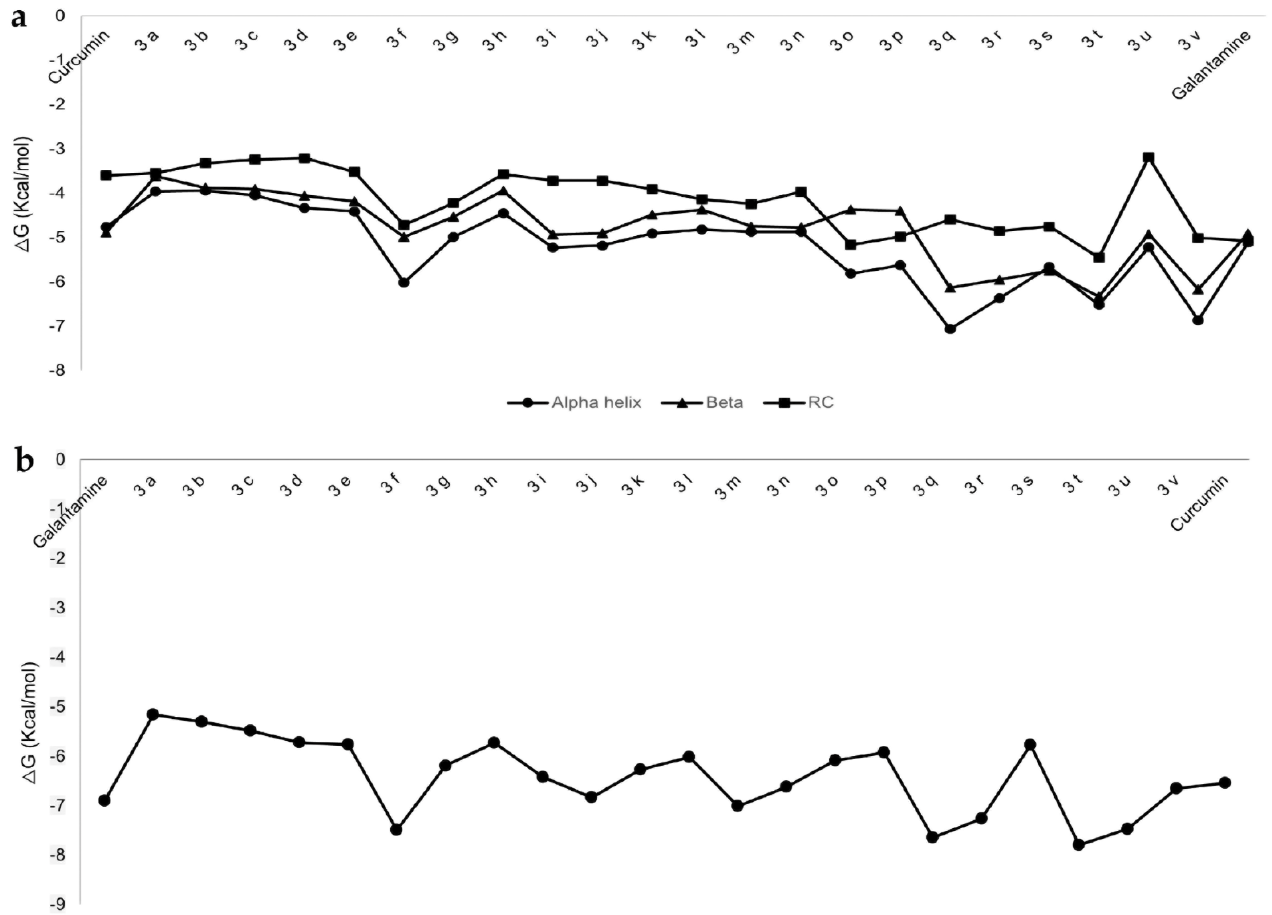
Figure 2. Free energy ( ∆ G; kcal/mol) values obtained by docking simulations. ( a ) A β 1-42 in α -helix, β -sheet and RC conformations with the benzothiazole-isothiourea and its control compound curcumin. ( b ) AChE with the benzothiazole-isothiourea derivatives and its control compound galantamine.